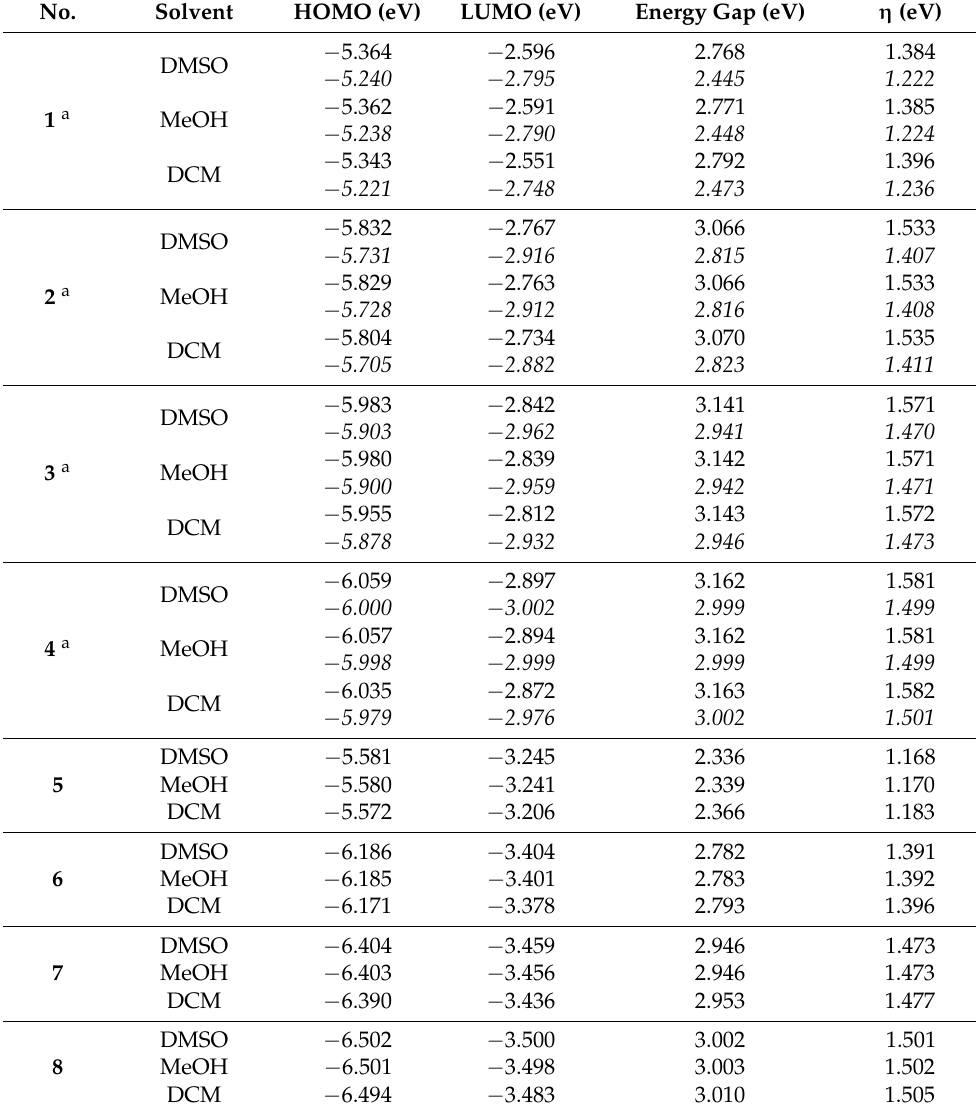
Table 4. The values of hardness ( η ), energy gap, and energies of HOMO and LUMO orbitals estimated for all compounds 1–8